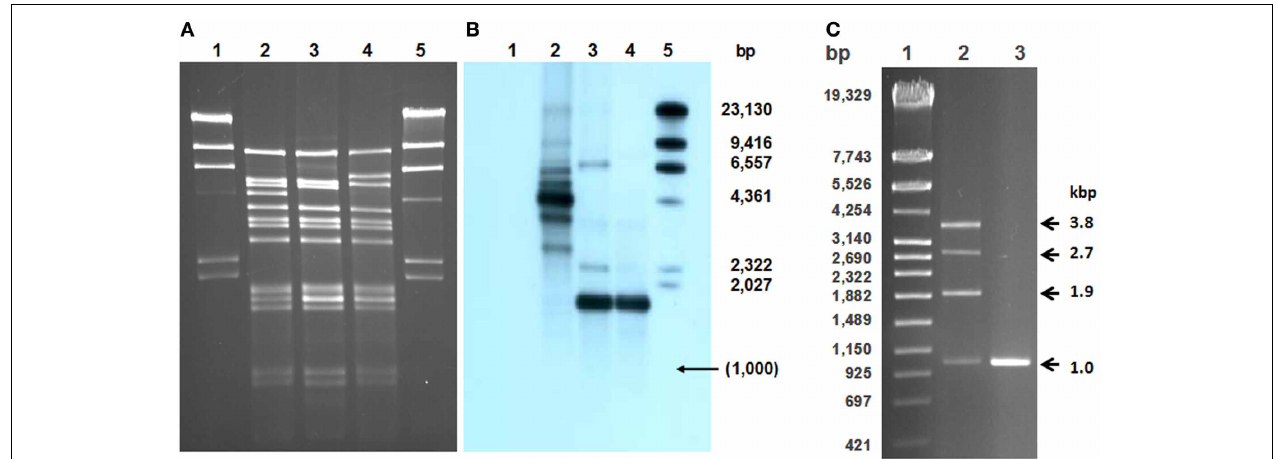
FIGURE 1 | Comparison of TP-J34, TP-J34L, and TP-EW genomic DNAs. Agarose gel (A) and corresponding Southern blot (B) of HindIII-cleaved DNAs of TP-J34 (lane 2), TP-J34L (lane 3), and TP-EW (lane 4) hybridized with DIG-labeled 1kb probe generated from 1.7kb HindIII fragment of TP-J34L. Lanes 1 and 5: unlabeled and Dig-labeled λ -DNA, respectively. Sizes of